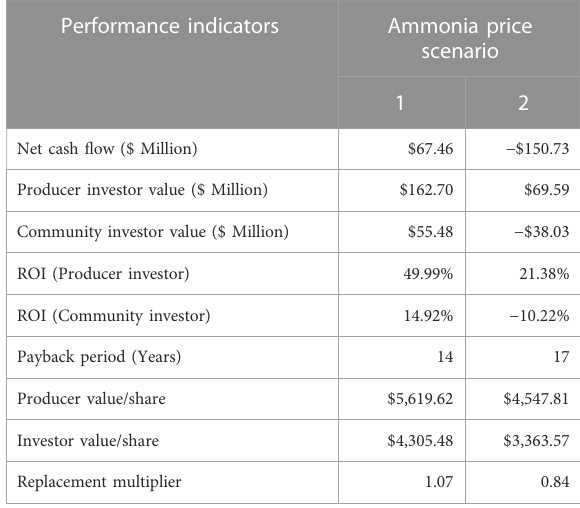
TABLE 9 Discounted performance indicators under debt fi nancing II (producers = 35%; community = 15%; debt = 50%) with a discount rate of